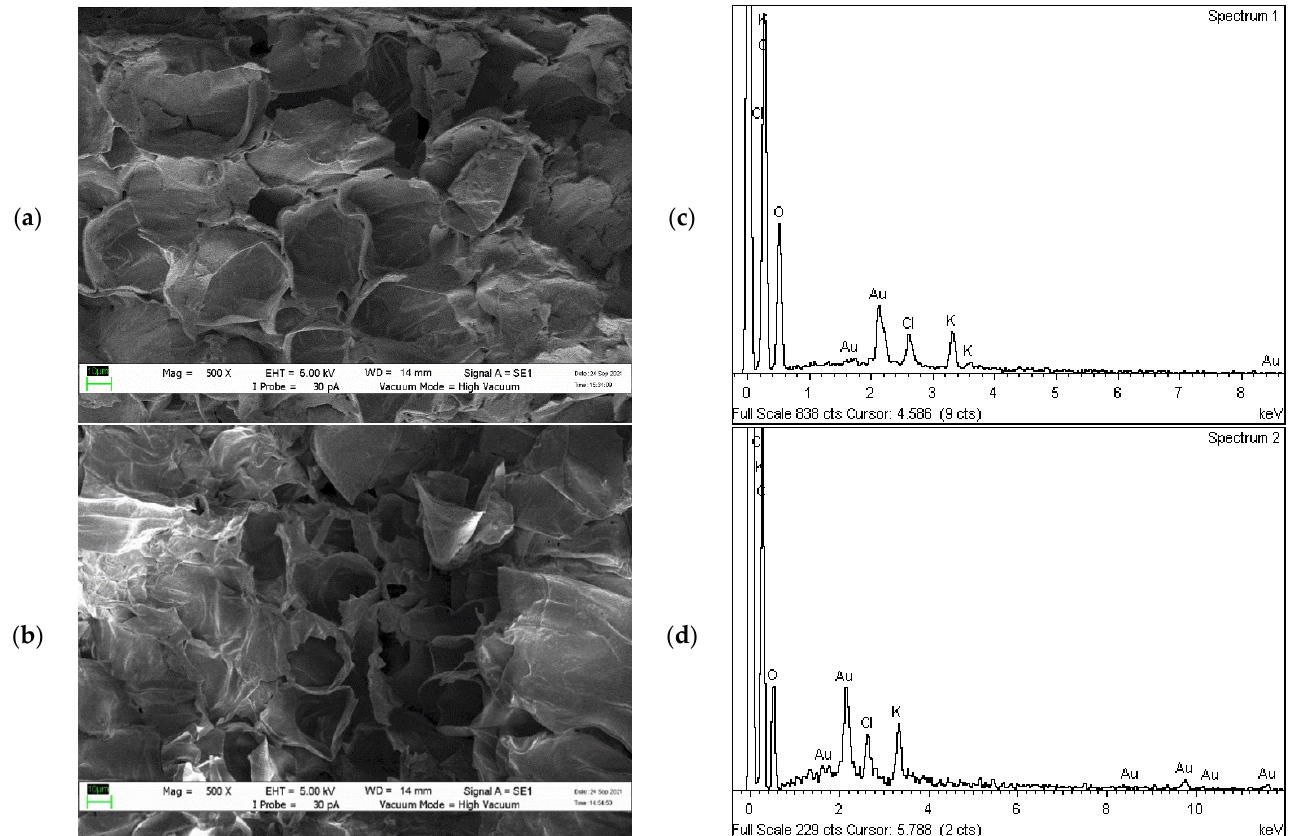
Figure 3. SEM and EDX analysis before filtration: ( a , c ) UNT CP and ( b , d ) T CP.